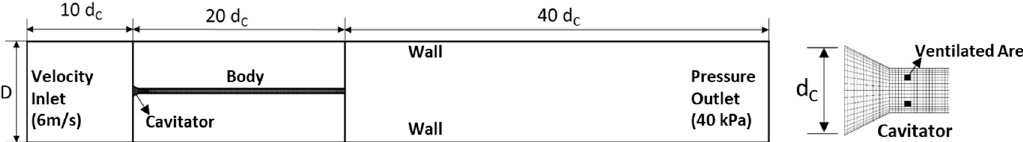
Figure 5. Schematric view of the computational model and boundary conditions.